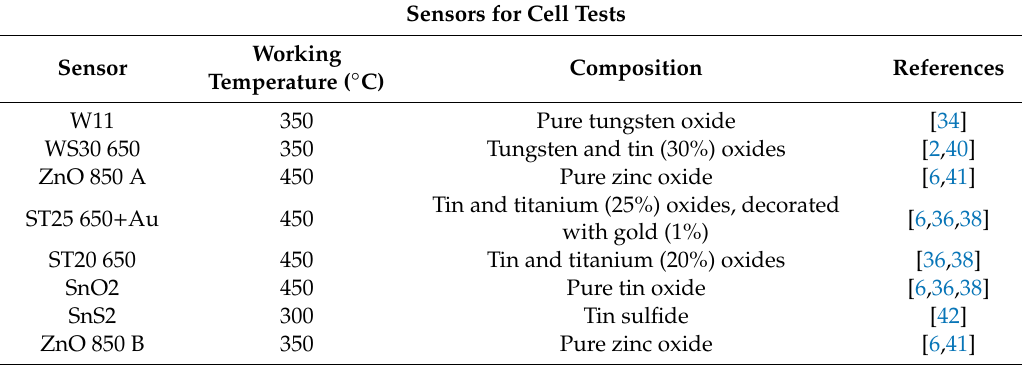
Table 2. Sensors used for cell tests, their working temperature, a brief description of their composition, and references to other works in which they are described in depth and their characterizations are